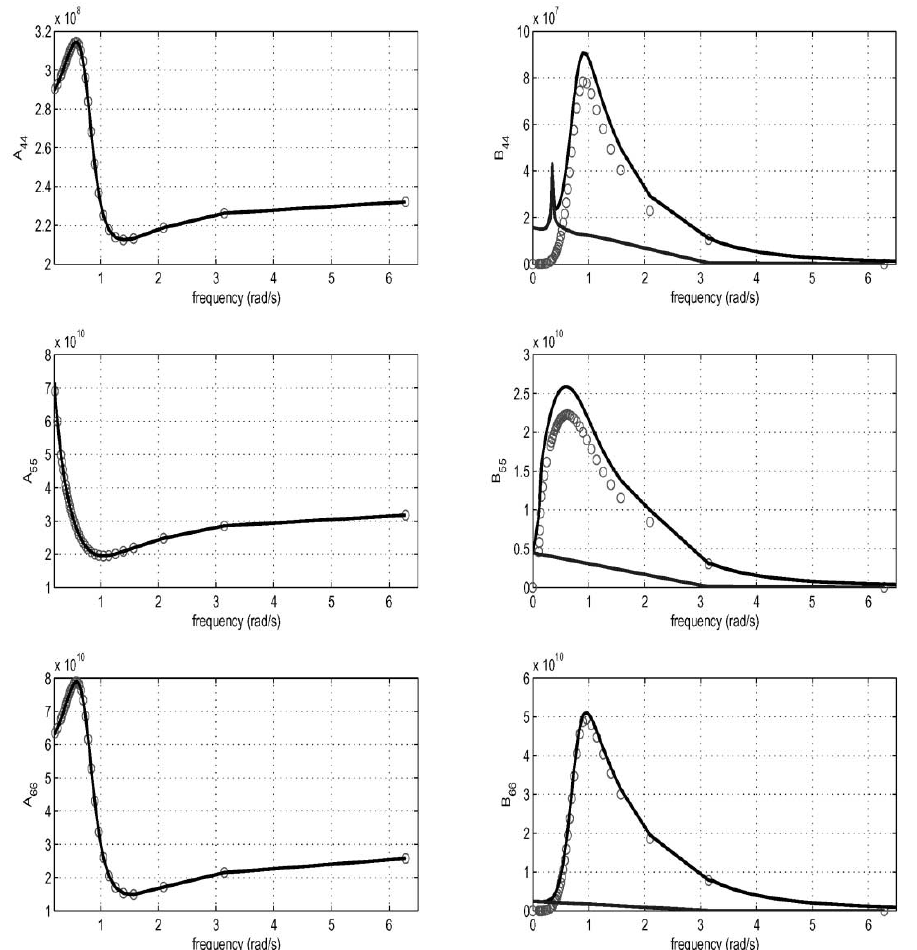
Figure 9. Frequency dependent added mass A B for the S-175 container ship. Circles indicates VERES data points while the solid line is 66 due to interpolation. For the B addition a viscous ramp function is added to the B bilge keels (and possible anti-roll tanks) is included in the B